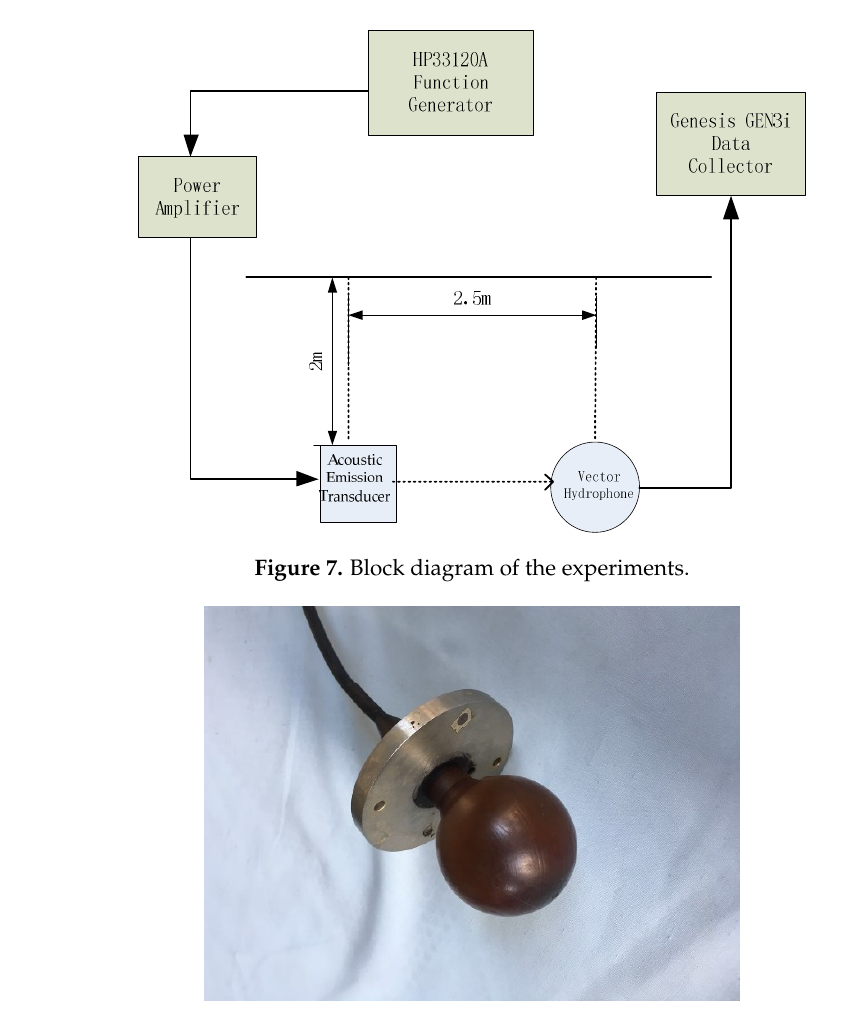
Figure 8. The vector hydrophone.